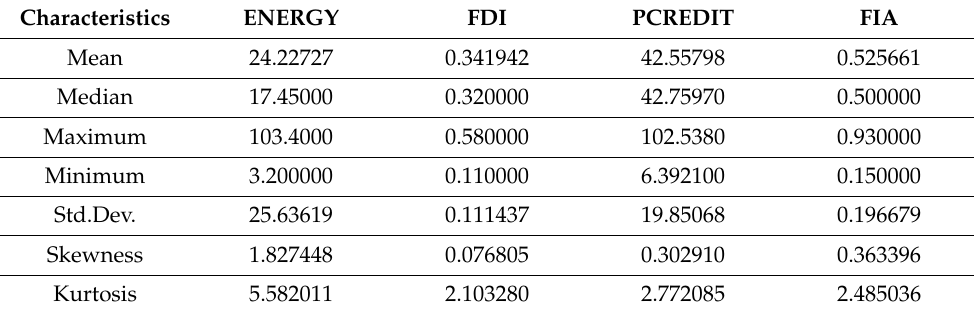
Table 2. Main characteristics of the